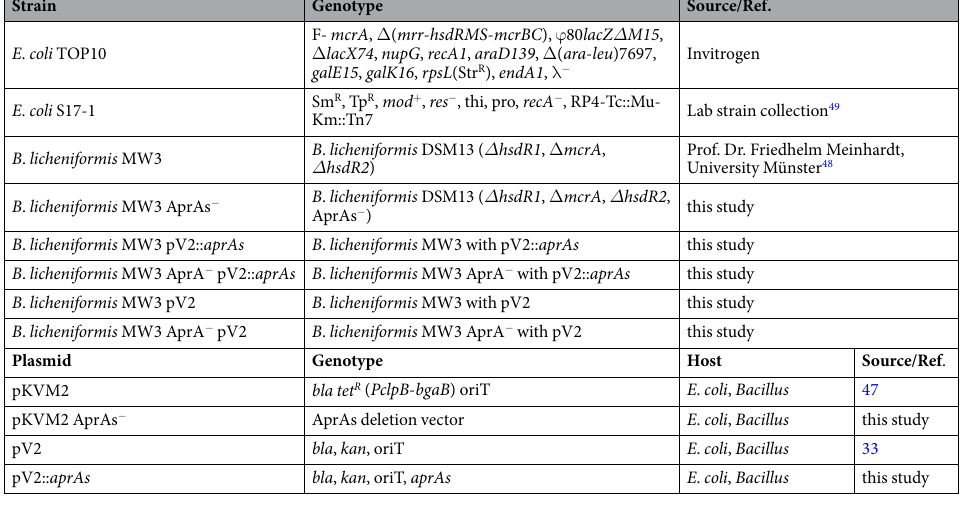
Table 1. Bacterial strains und